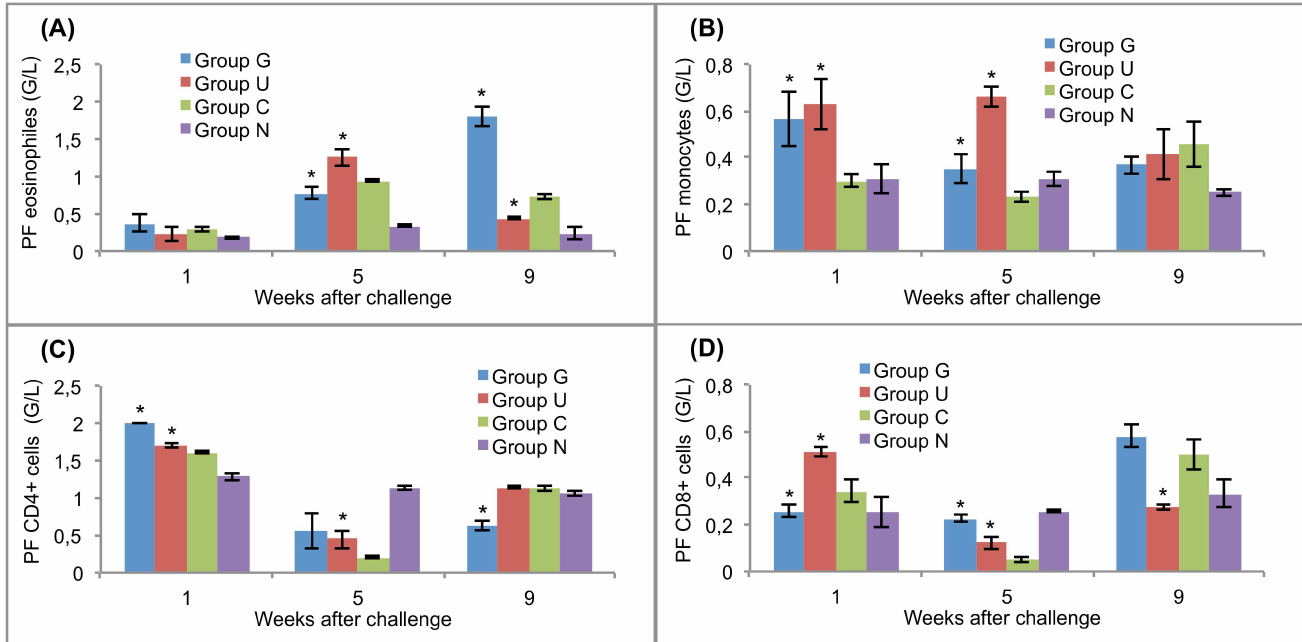
Fig 5. Leukocyte responses in the peritoneal cavity of vaccinated and control rats to challenge infections. (A) eosinophils. (B) monocytes. (C) CD4+ T lymphocytes. (D) CD8+ T lymphocytes. Group G–Lyophilisedlettuce expressingthe mature CPFhW enzyme flankedby Gly-rich linkers; Group U–Lyophilised lettuce expressingthe mature CPFhW protein fused with ubiquitin;Group C–Lyophilised control lettuce; Group N–None. At each timepoint, four rats from each group were euthanised and dissected. * Indicatessignificantly increasednumbers of cells ( p < 0.05). Error bars indicate standard deviation.